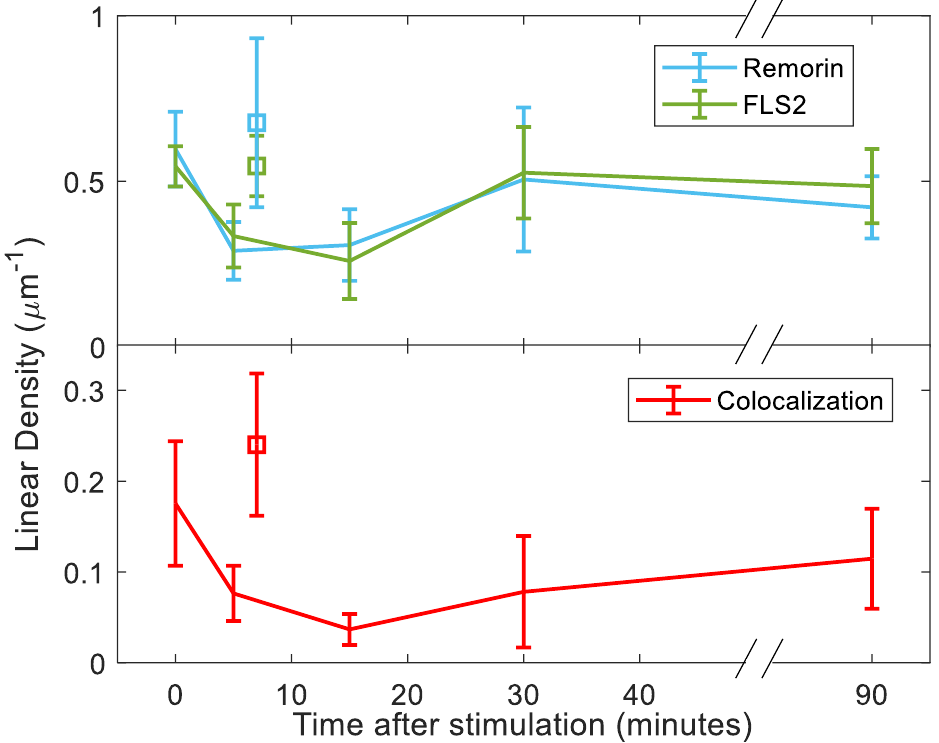
Figure 2. Time series post-stimulation with 200 nM of flg22 showing the linear density of ( a ) FLS2 and remorin, ( b ) colocalization of FLS2 within 100 nm of remorin. Squares indicate alternative sample of unstimulated points for comparison.